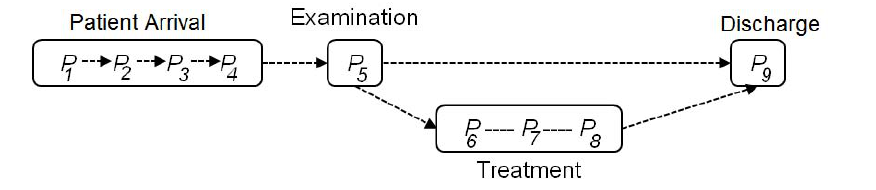
Figure 10. Detailed patient Intrapartum model